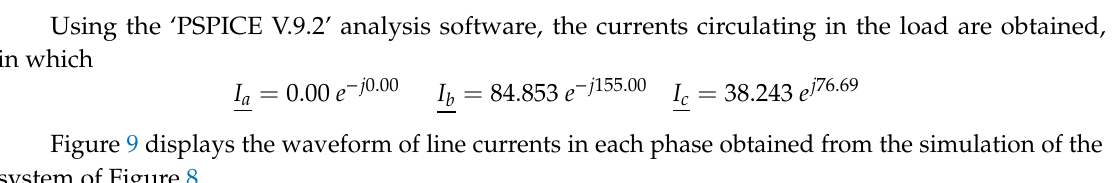
Figure 8. Proposed system for practical application.